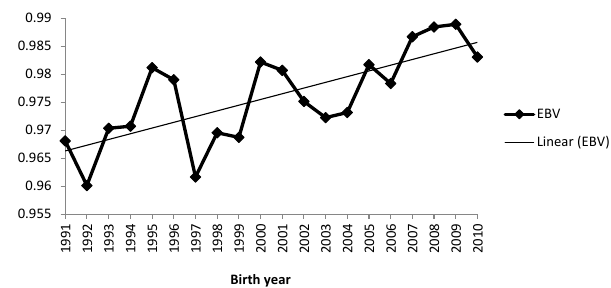
Figure 5. Averaged breeding values of proportional culling risk in sire